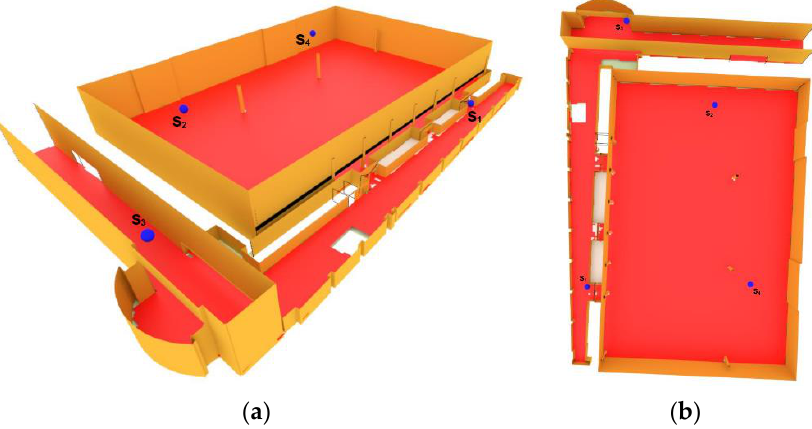
Figure 12. Final locations of cameras obtained by the 3D Voronoi approach are shown in ( a ) side view and ( b ) top view.